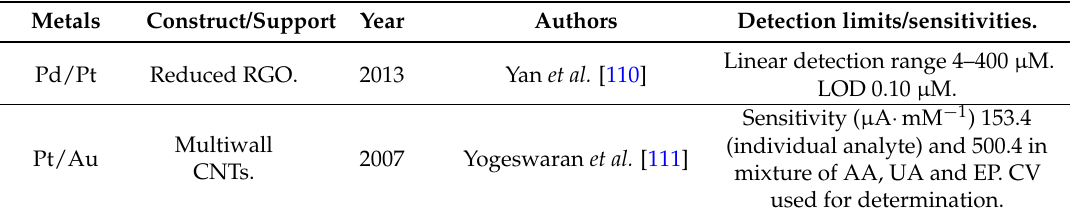
Table 4. Metals and constructs used for sensors designed to sense uric